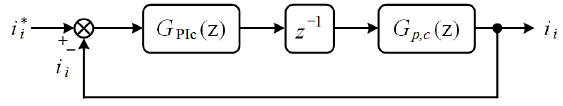
Figure 7. Block diagram of the current control in GC